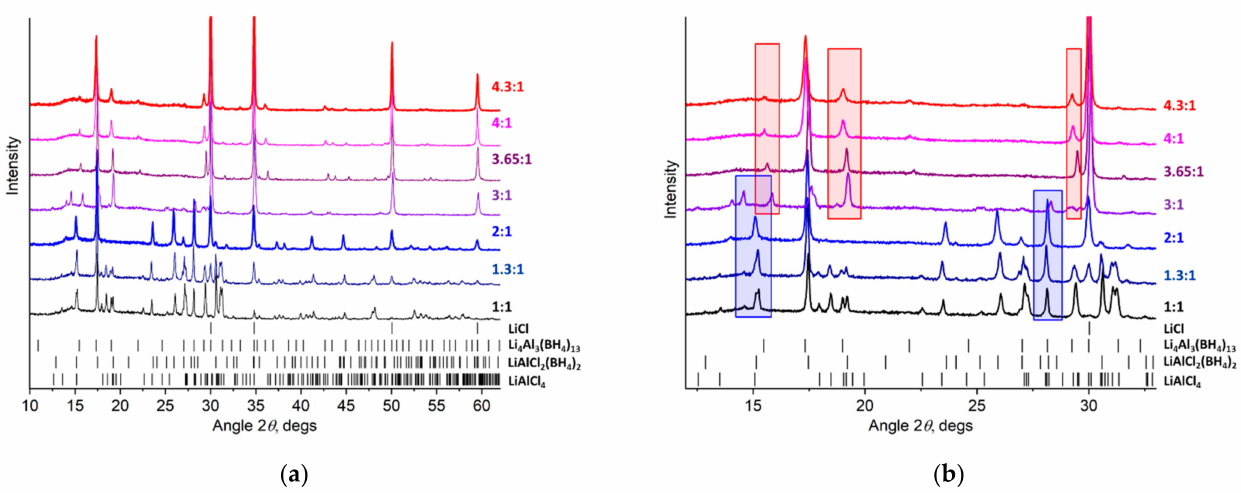
Figure 1. ( a ) Powder XRD patterns of samples with different LiBH 4 /AlCl 3 ratios ball-milled for 3 h; ( b ) details between 12 and 33 ◦ of 2 θ , where the Bragg reflections of the Li 4 Al 3 (BH 4 ) 13 phase are highlighted by the pink rectangles and those of the LiAlCl 2 (BH 4 ) 2 phase are highlighted by the blue rectangles. Locations of the Braggs peaks of the reaction products are shown as the vertical markers at the bottom of the plot; for Li 4 Al 3 (BH 4 ) 13 and LiAlCl 2 (BH 4 ) 2 the locations are for the ideal stoichiometries observed at 4.3:1 and 2:1 molar LiBH 4 :AlCl 3 ratios,